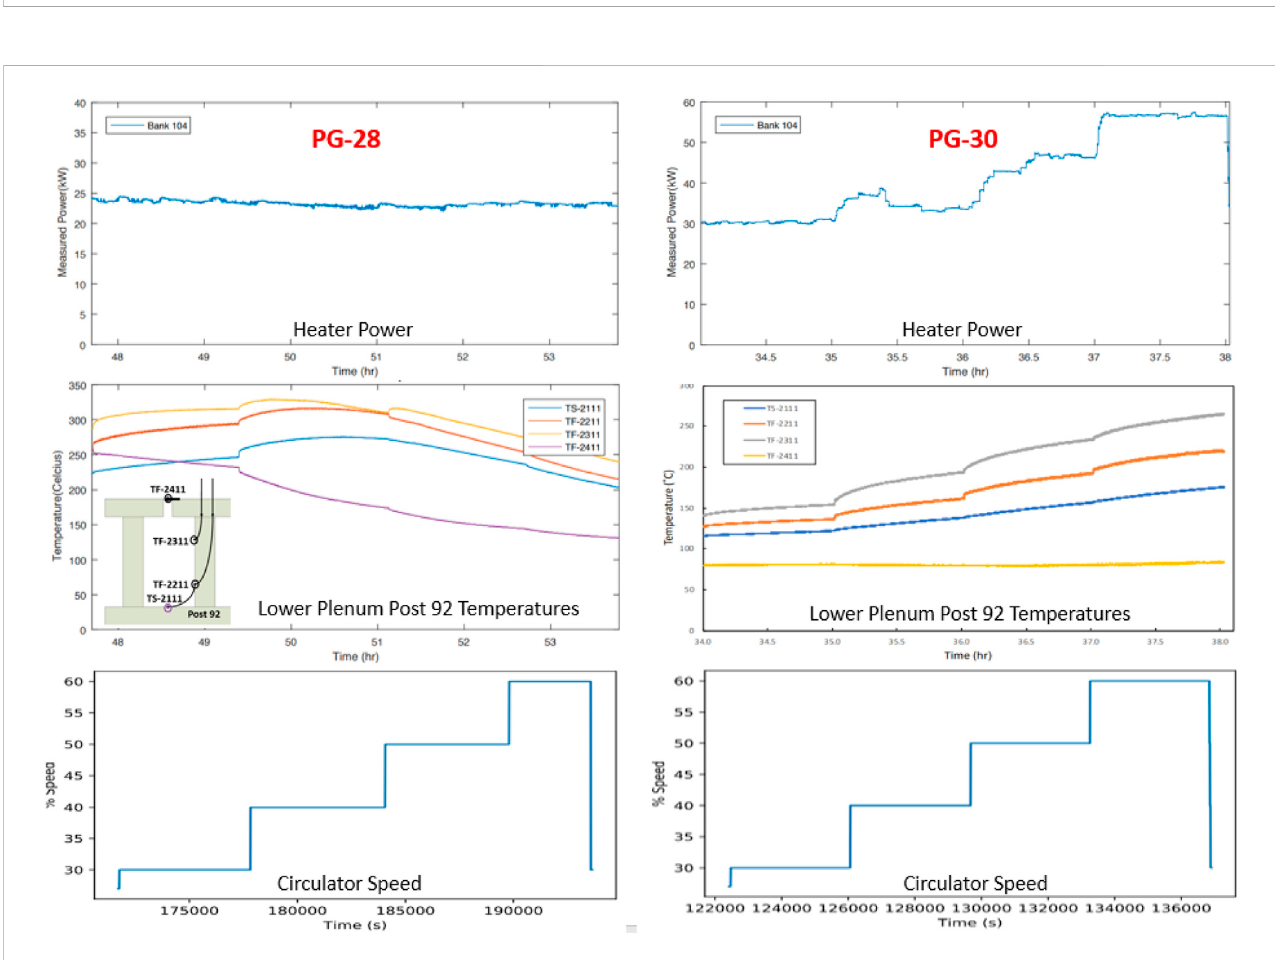
Frontiers in Energy